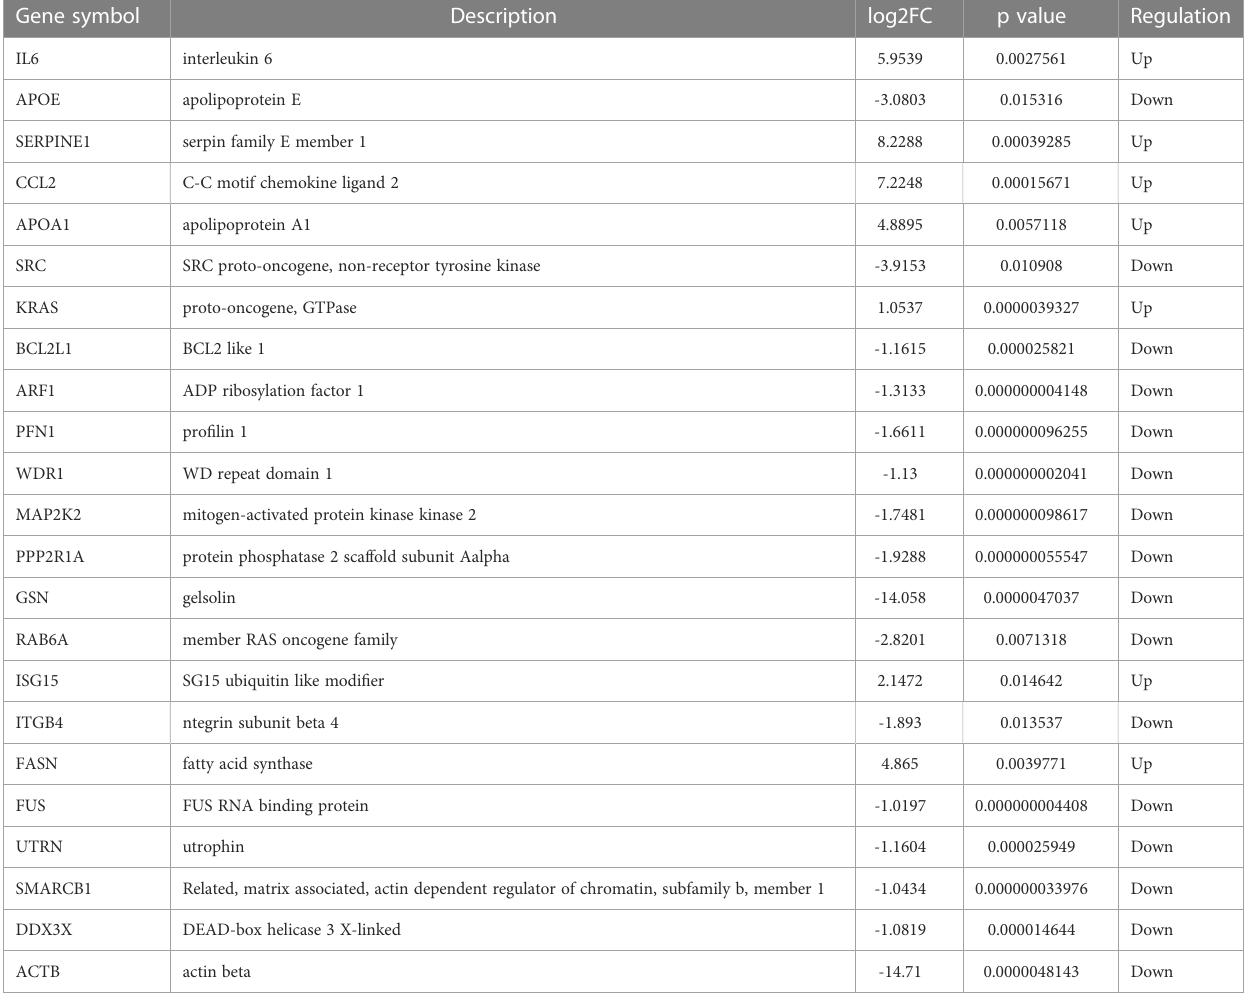
TABLE 3 Hub genes are identi fi ed by 8 algorithms of cytoHubba. Gene